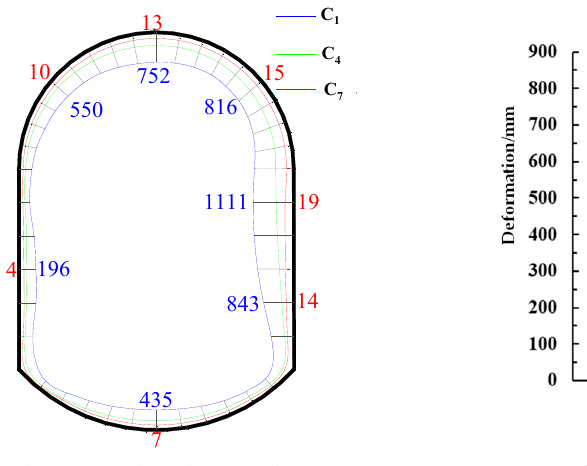
Figure 9. Displacement analysis of different lining thickness. ( a ) Displacement distribution diagram ( b ) Displacement of left and right shoulder